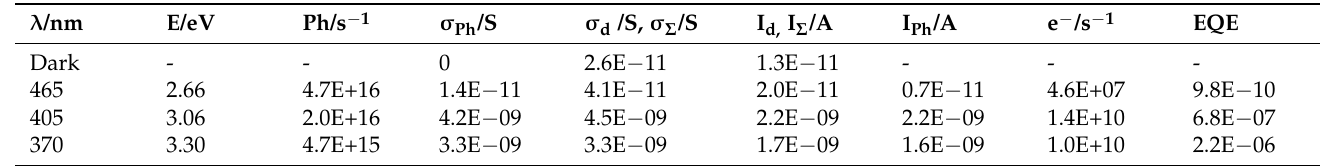
Figure 5. ( a ) SAED containing the two TiO 2 phases (yellow—anatase, red—rutile); ( b ) DCDF settings (red annulus—planes (011) of anatase and planes (110) of rutile; green annulus—planes (011) of anatase (OA shows the size and position of objective aperture); ( c ) RGB composite image, in which green represents BF TEM, yellow shows the planes (011) of anatase, and red shows the planes (110) of rutile; ( d ) the composite image of grayscale BF TEM and red DCDF corresponding to planes (110) of rutile. Table 1. Results of DC electrical measurements for TiO 2 Spikelet layer.